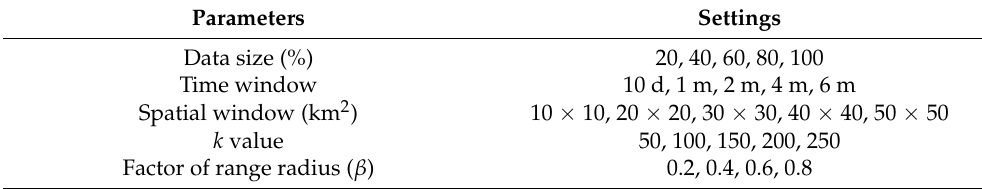
Table 4. The configuration of query